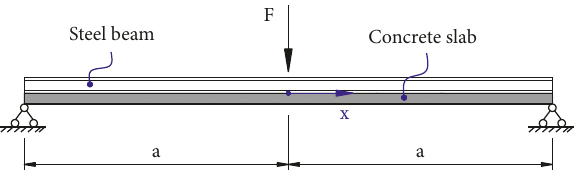
Figure 10: Schematic of the static load test of the inverted beam. Table 3: Parameters of the inverted steel-concrete